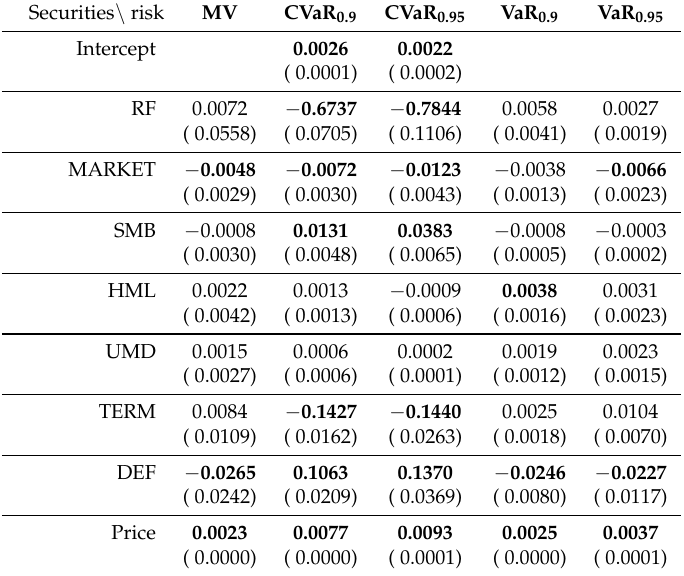
Table 1. Hedging of Inflation. The table reports the estimates and their corresponding bootstrap errors (based on 400 bootstrap replications) for different risk measures (mean-variance MV, conditional value-at-risk CVaR, and value-at-risk VaR). The bold font represents statistical significance (at the 5% nominal level) of individual coefficients except for the last row where the bold font signifies a statistically different price from E ( y ) .